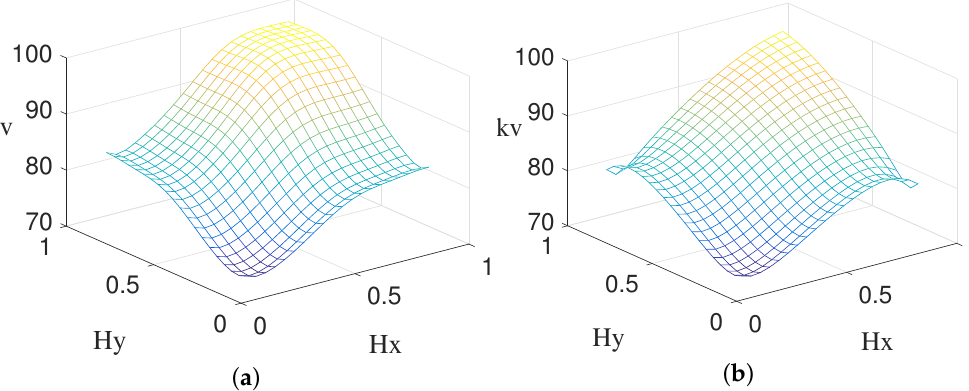
Figure 9. The effect of different H x , H y on v and kv when ( x , y , z ) = ( 100,100,100 ) and H z =